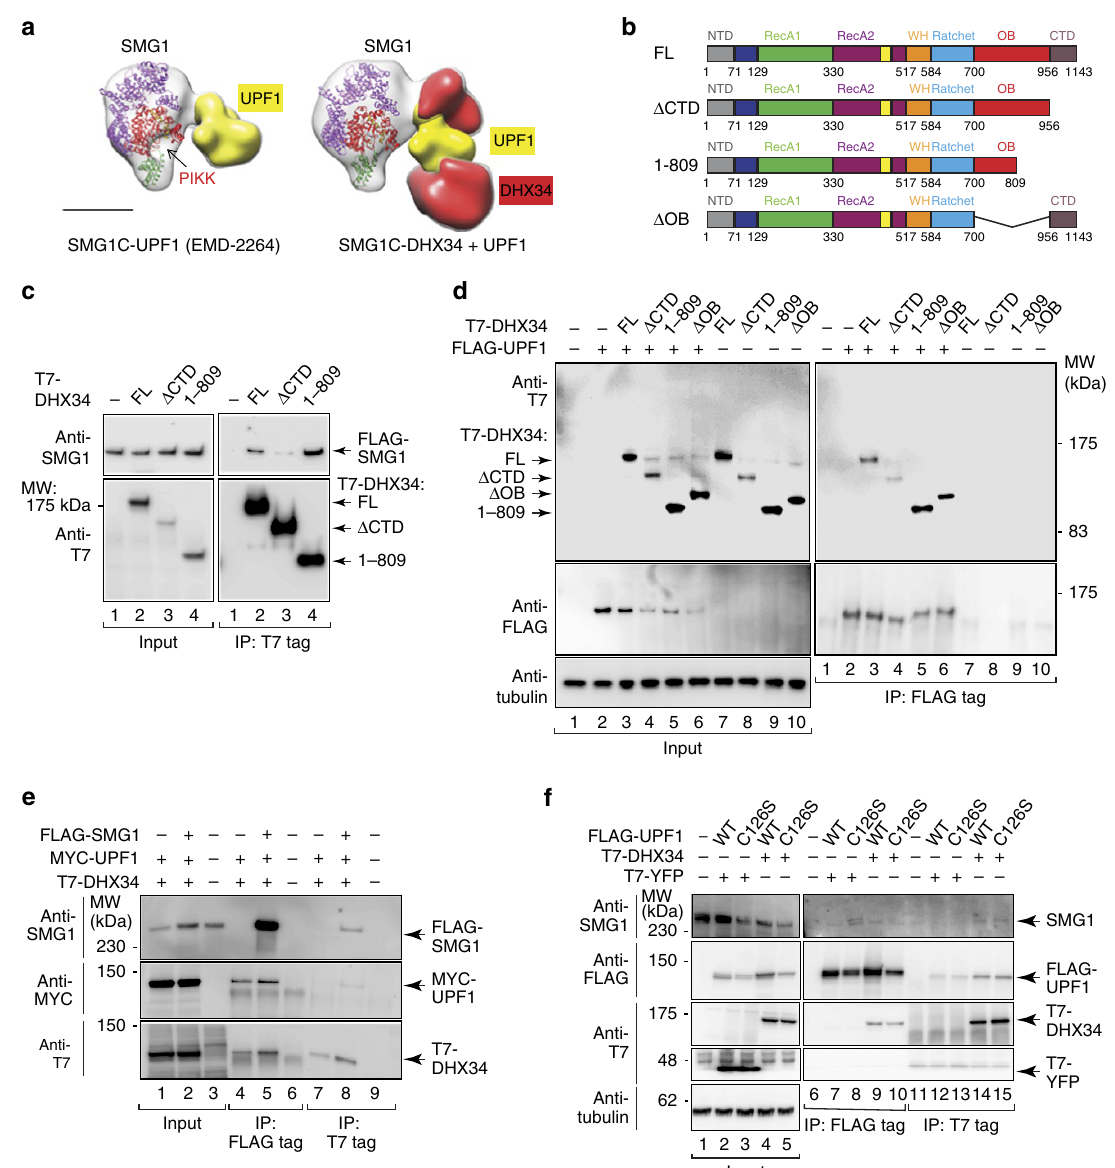
Figure 5 | DHX34 can bind SMG1 via its CTD domain or via binding to UPF1. ( a ) Overlap between the structures of SMG1C–DHX34 and SMG1C-UPF1 (EMD-2264) 21 , revealing that the formation of a putative SMG1C-UPF1-DHX34 complex is structurally feasible. The putative location of the SMG1 kinase domain is indicated as PIKK in red. Scale bar, 5nm. ( b ) Cartoon depicting the domain structure of DHX34 full-length (FL) and C-terminal deletion mutants. ( c ) HEK293T cells were transfected with full-length T7–DHX34 and DHX34 C-terminal deletion mutants shown in b . Inputs (0.5%) and anti-T7 immunoprecipitates (20%) were probed for the presence of SMG1. Expression of T7–DHX34 constructs was detected with an anti-DHX34 antibody. ( d ) Analysis of the binding of T7–DHX34 (FL and C-terminal deletion mutants) to FLAG-UPF1. HEK293Tcells were transfected with full-length T7–DHX34 or DHX34 C-terminal deletion mutants and FLAG-UPF1. Inputs (0.5%) and anti-FLAG-immunoprecipitates (20%) were probed for the presence of